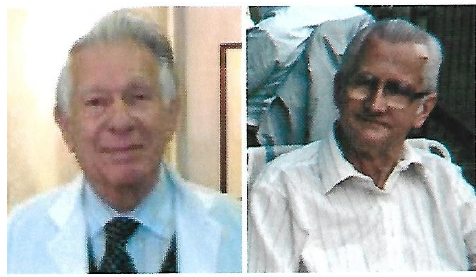
Figure 1. Dr. C. Caceres (left) and Dr. H. Pipberger (right).